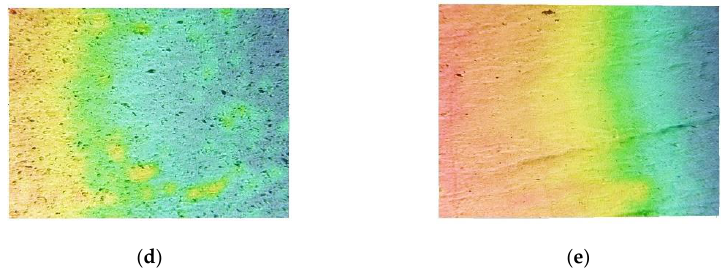
Figure 24. The surface appearance of five regions after 5 h processing: ( a ) L1, ( b ) L2, ( c ) L3, ( d ) L4, ( e ) L5.